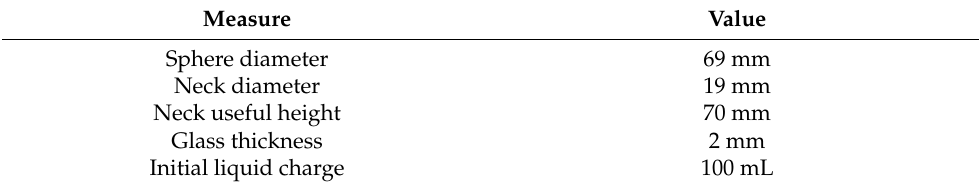
Table 3. Main measures of the distillation